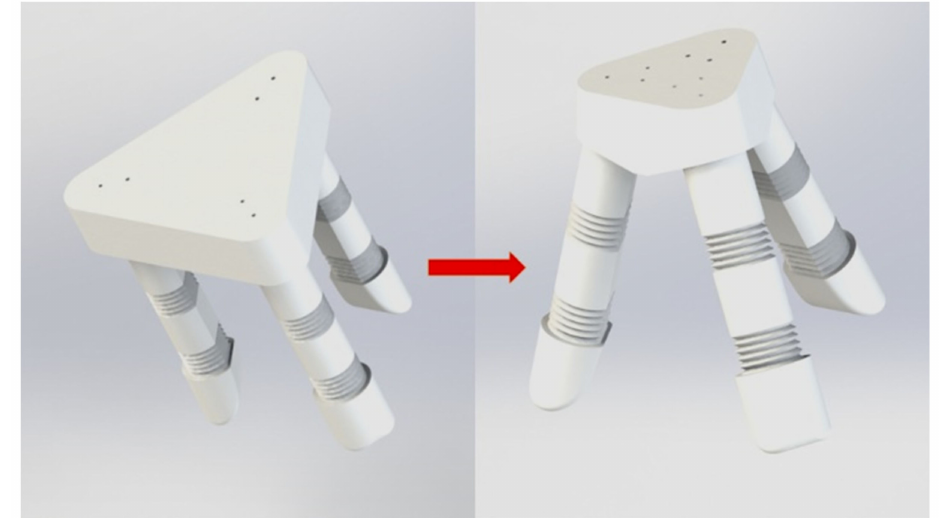
Figure 3. Illustration of the proposed design change to the gripper